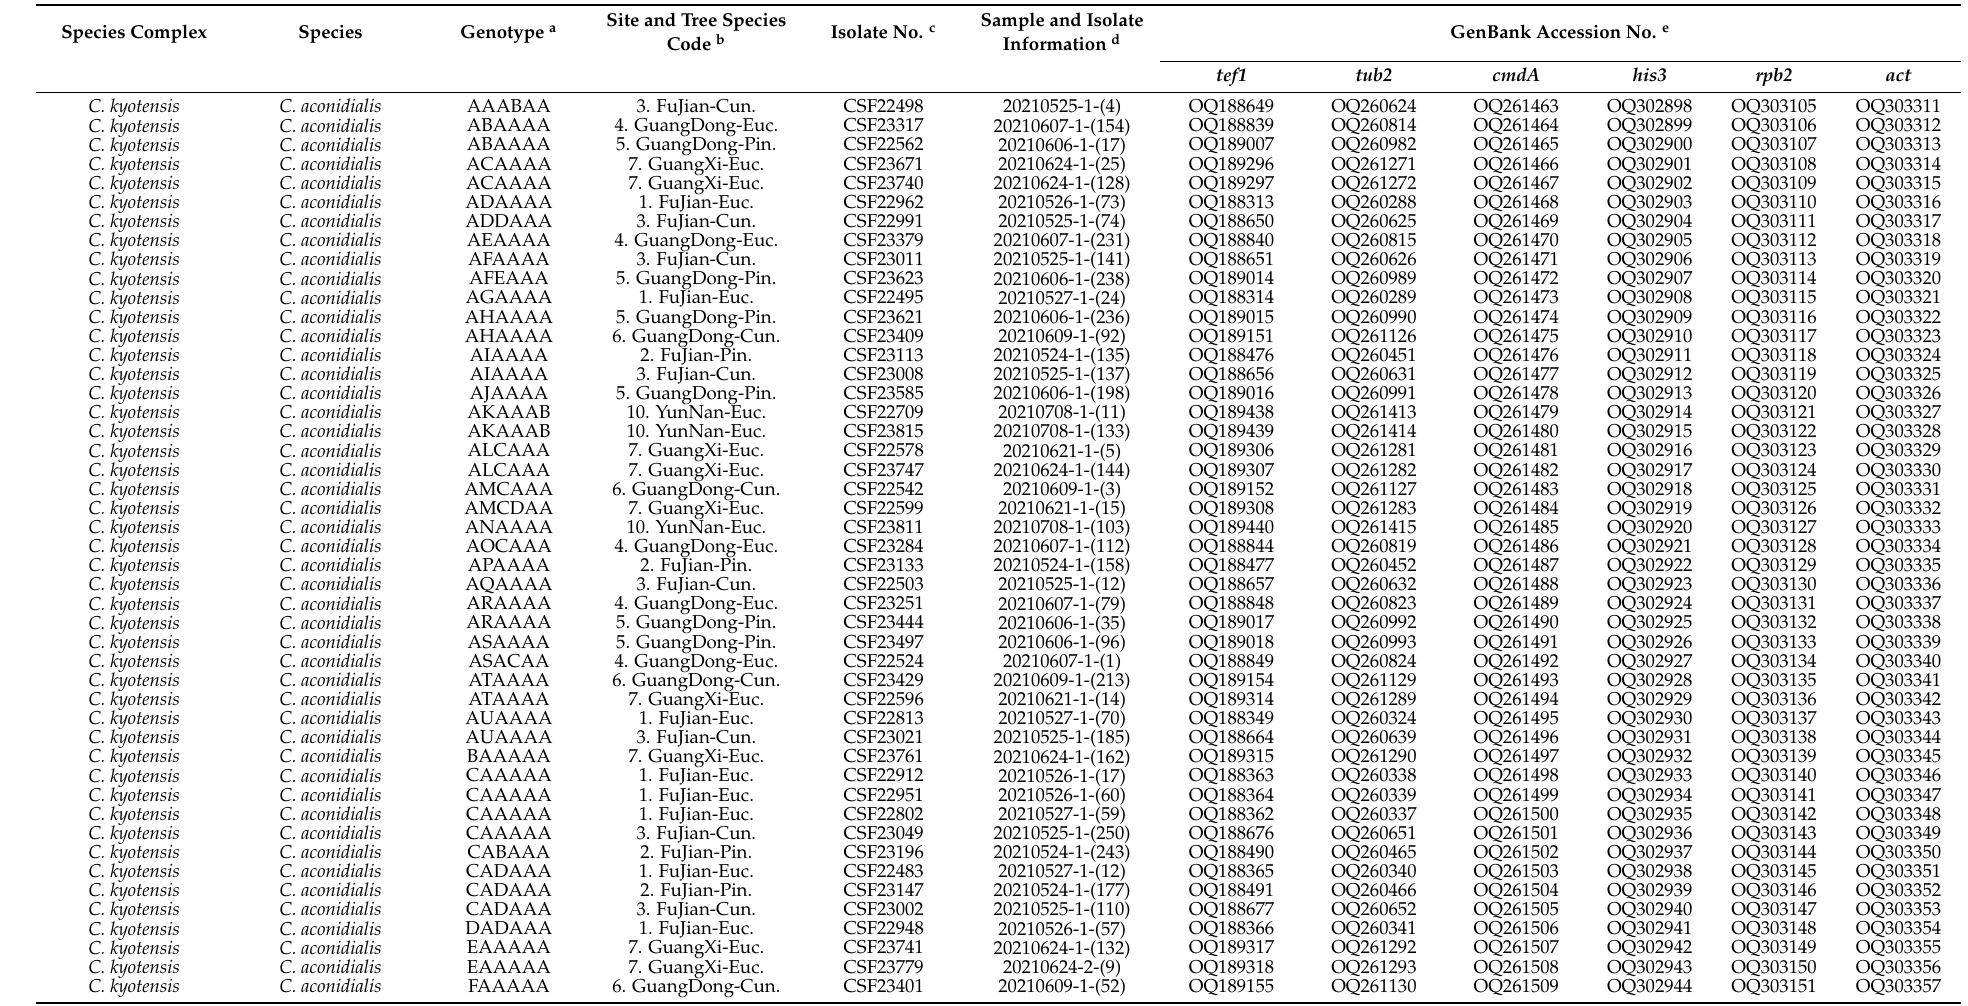
Table 3. Isolates sequenced and used for phylogenetic analyses in this